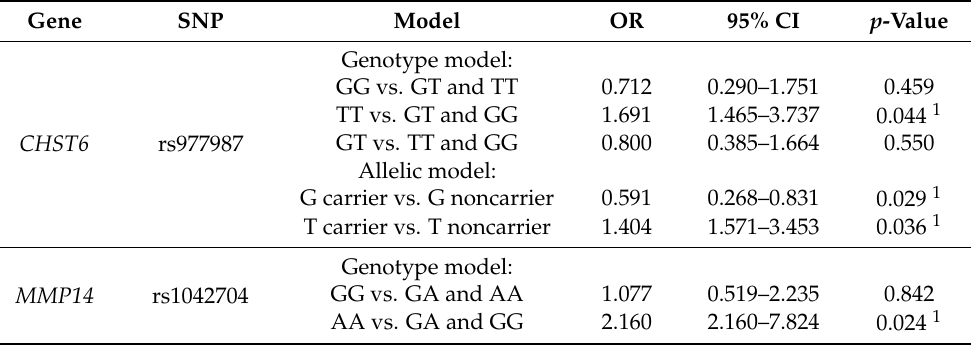
Table 5. The associations of CHST6 and MMP14 polymorphisms with the previous onset of the Dupuytren’s